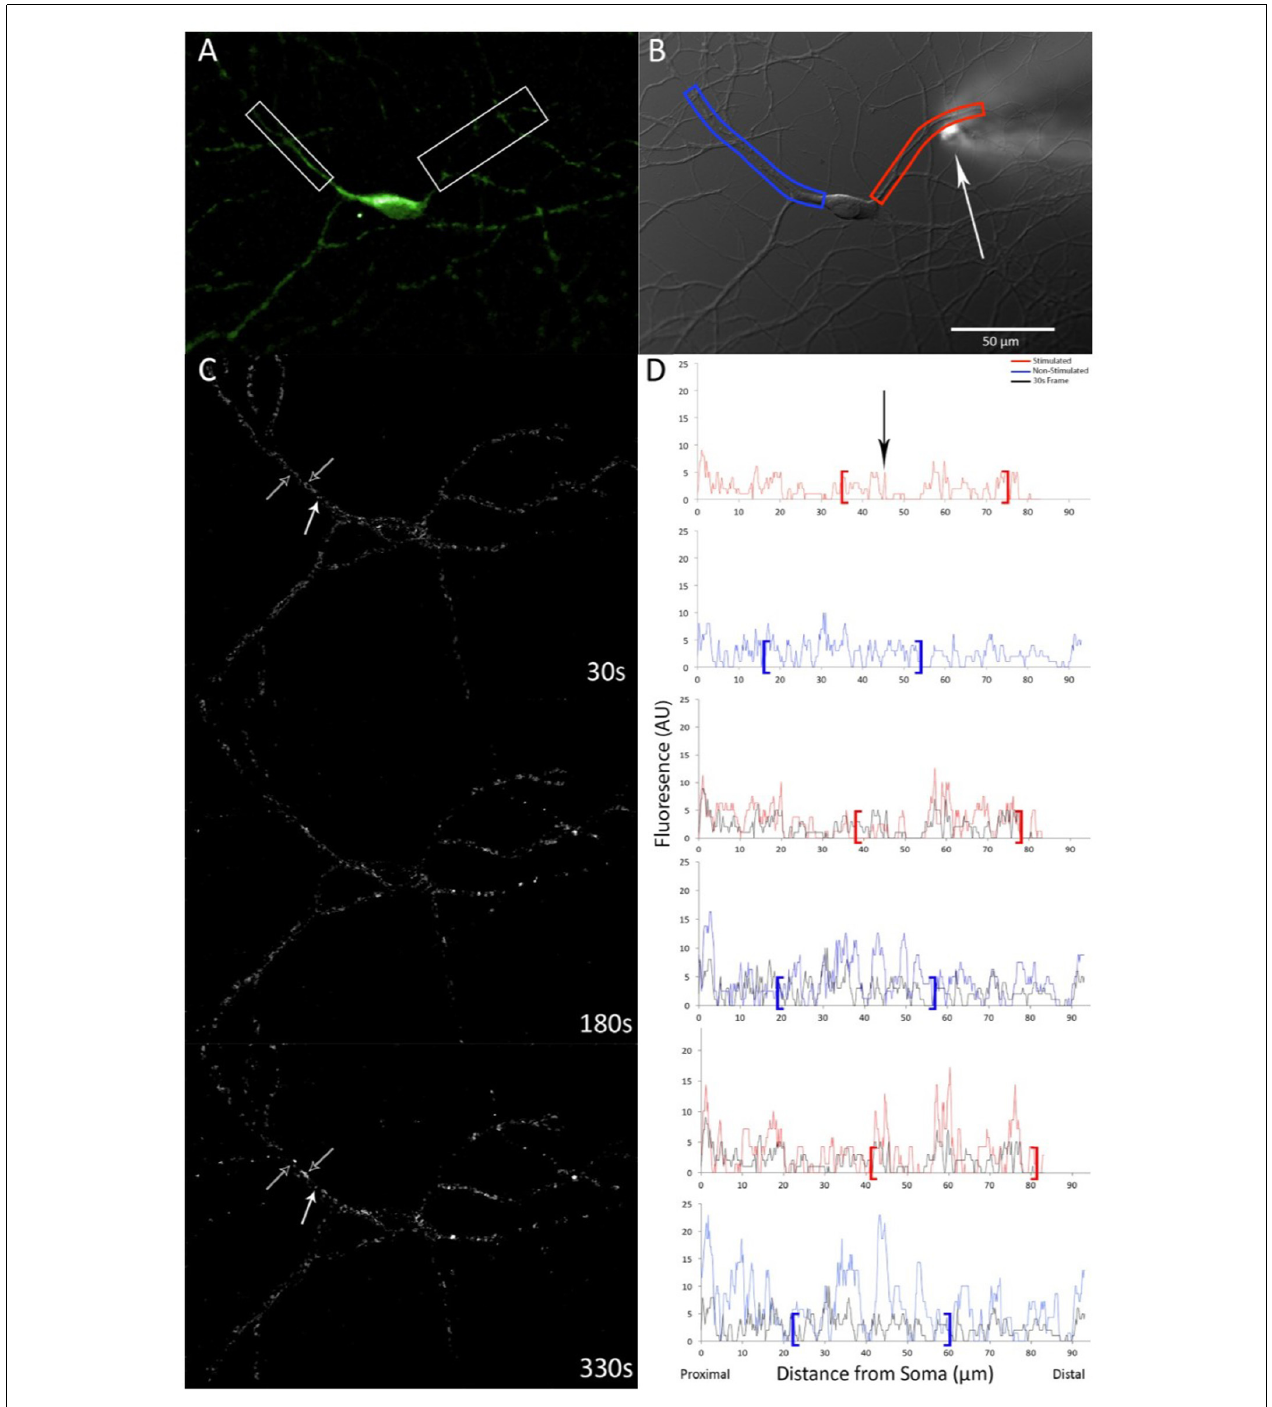
FIGURE 1 | GFP-calcium-calmodulin-dependent protein kinase (CaMKII) expression and translocation after stimulation with 100 µ M glutamate with 10 µ M glycine via pipette. (A) GFP-CaMKII expression prior to stimulation. (B) DIC image of the same neuron with measured dendrites highlighted in red (right) and blue (left) and an arrow indicating the position of the micropipette. Scale bar = 50 µ m. (C) Time-lapse subtraction images (current fluorescence level minus initial fluorescence level; increases in fluorescence appear whiter while decreases are darker/black). Hollow white arrows indicate dendrite locations that show increased relative fluorescence over time, solid white arrow indicates the location where relative fluorescence level decreases. (D) Linescan measures of the same neuron shown in (C) indicating fluorescence levels for respective dendrites, red (top) and blue (bottom), starting proximal to the cell body. Brackets denote regions that correspond to boxes shown in (A,B) . Black linescan trace indicates fluorescence levels measured at first post-stimulation image capture for comparison. Arrowhead indicates the location of the stimulation pipette.